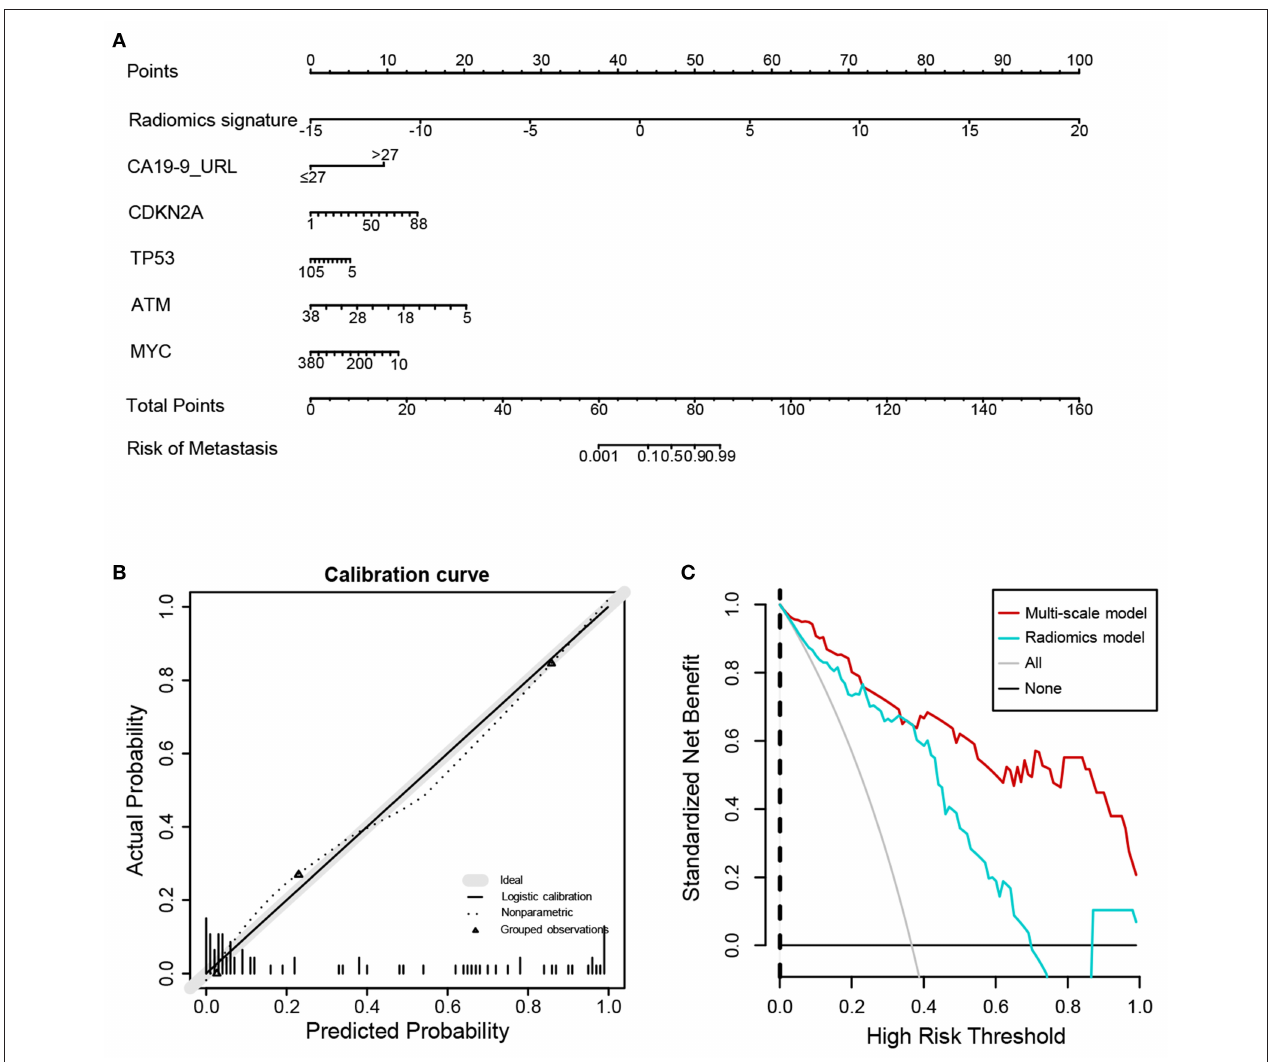
FIGURE 5 | Nomogram, calibration curve, and decision curve derived from the multiscale radiogenomics model. (A) Nomogram developed with the radiomics score, genomics, and CA-19-9. (B) Calibration curve analysis for the multiscale radiogenomics model. The y axis represents the actual probability of metastasis. The x axis represents the predicted probability of metastasis. (C) Decision curve analysis for the multiscale radiogenomics